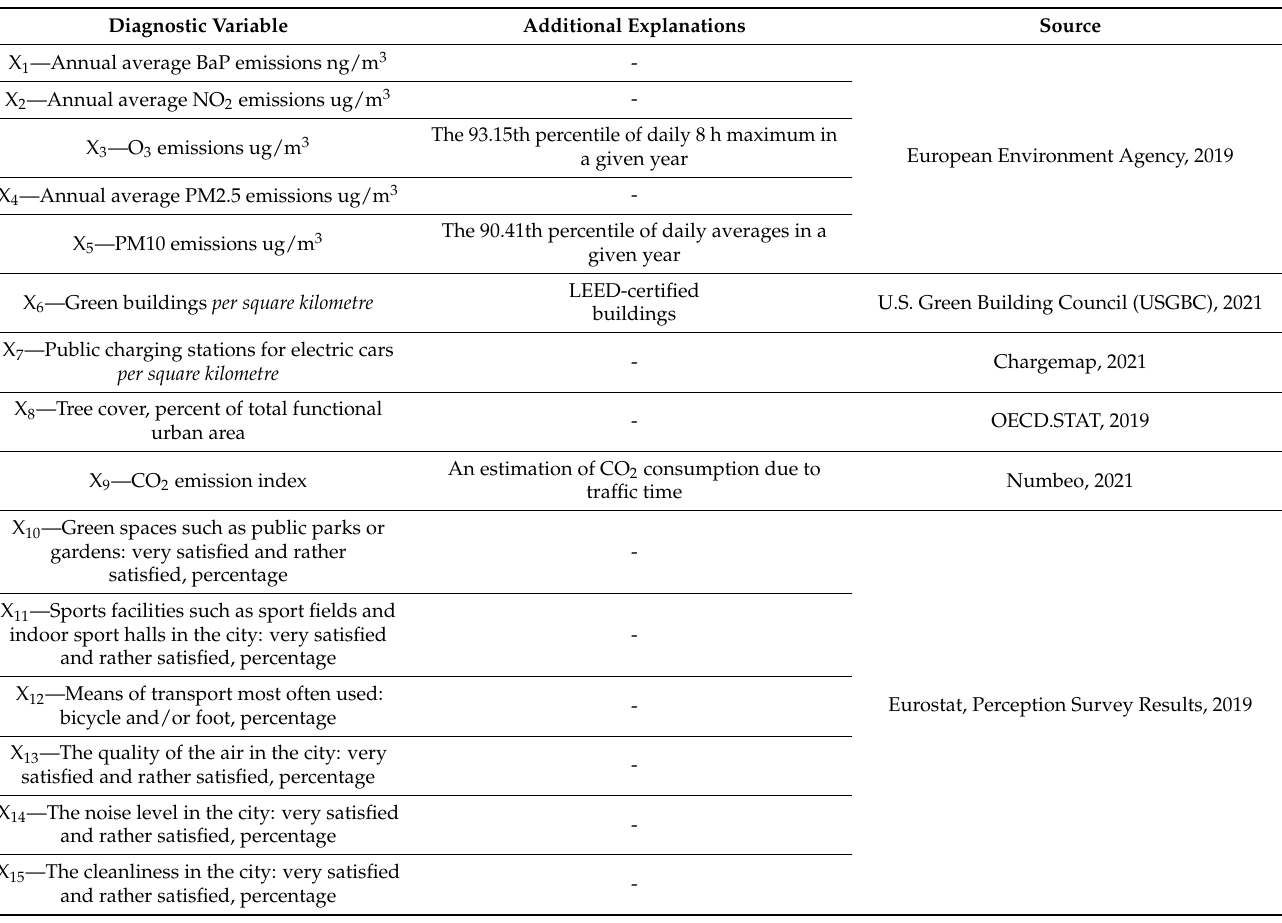
Table 1. Set of diagnostic